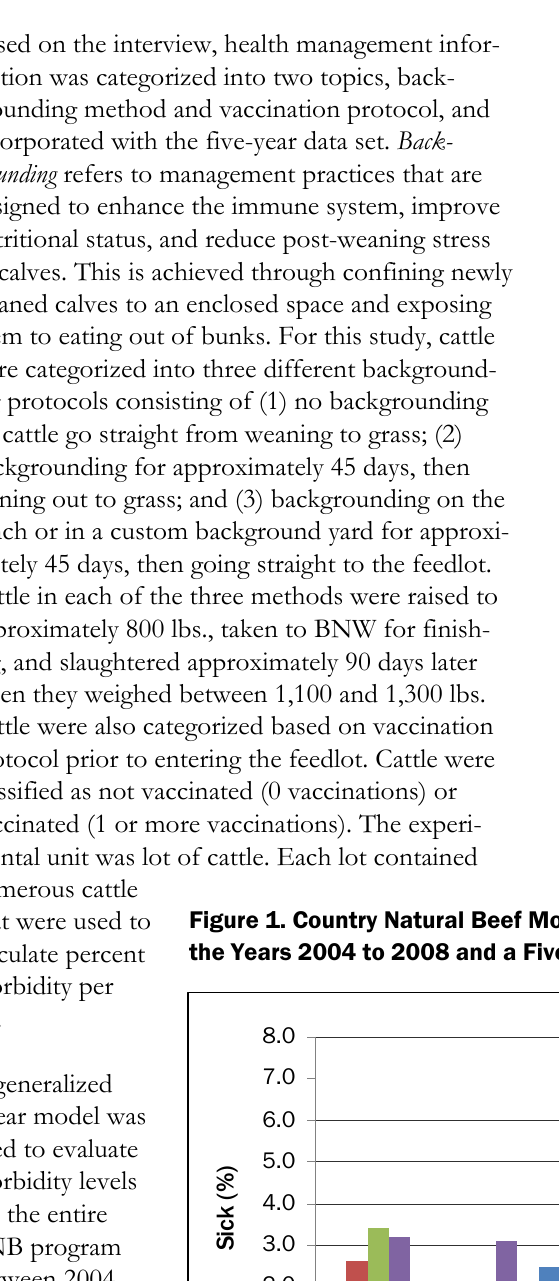
Figure 1. Country Natural Beef Morbidity Levels (sick, %) by Quarter for the Years 2004 to 2008 and a Five-year Average by Quarter